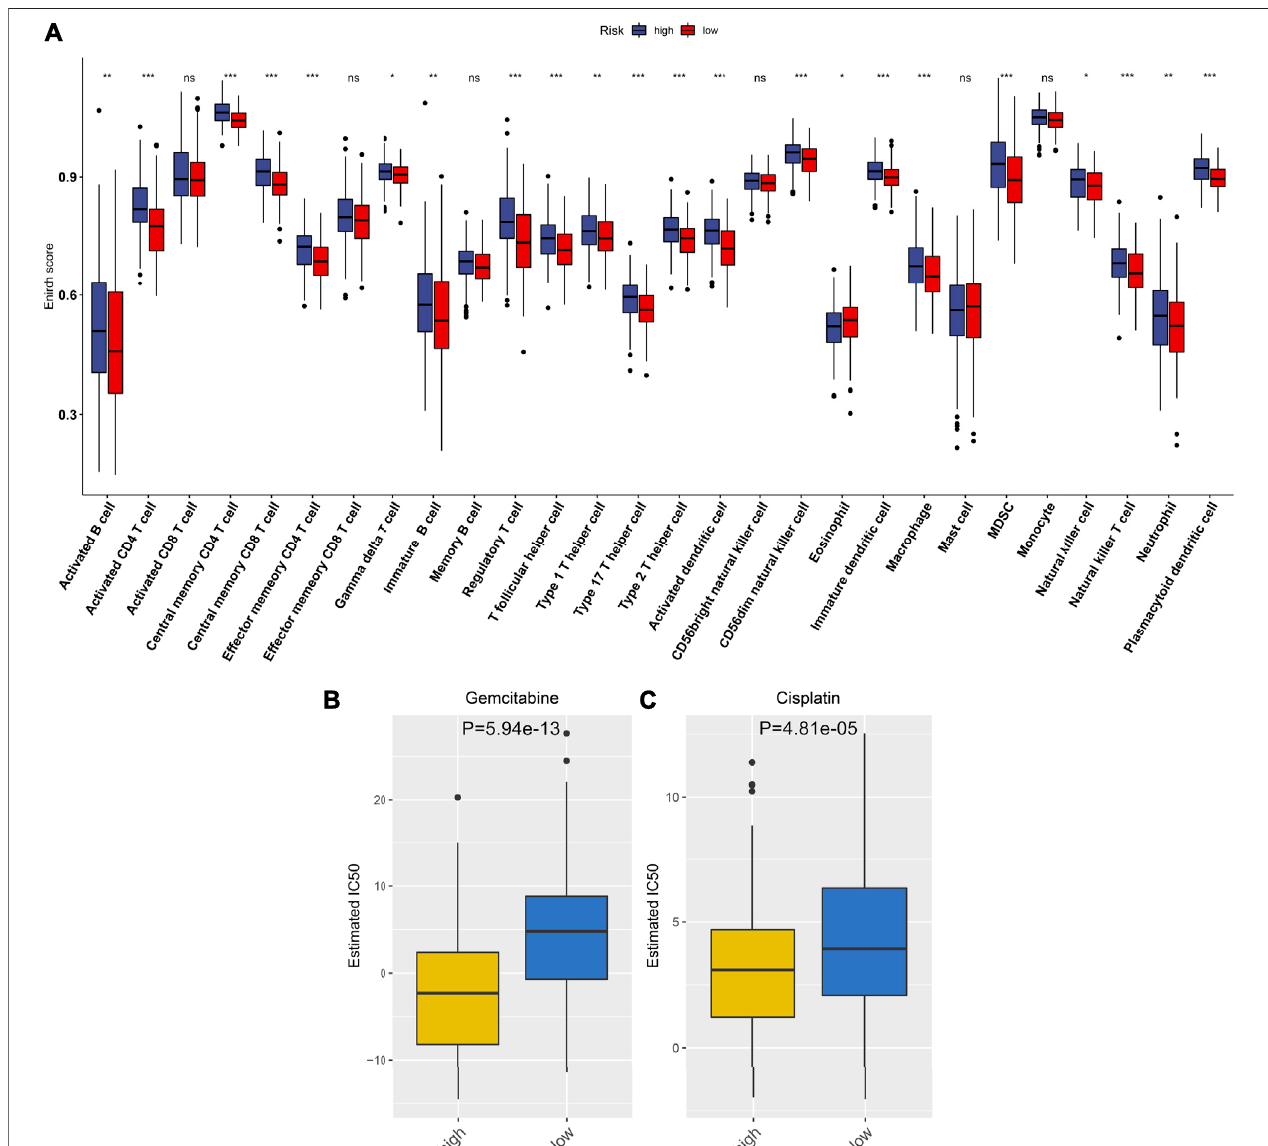
FIGURE 7 | Associations between the TLR-based signature and immune cell in fi ltrations and chemosensitivity of HCC in the TCGA cohort. (A) Comparisons of in fi ltration levels of immune cells between high and low TLR-based RS groups using the ssGSEA method. (B, C) Comparisons of the responses to gemcitabine and cisplatinbetweenhighandlowTLR-basedRSgroupsbyGDSCdatabase. p valueswereestimatedutilizingWilcoxonrank-sumtests.* p < 0.05;** p < 0.01;*** p < 0.001; ns: not signi fi